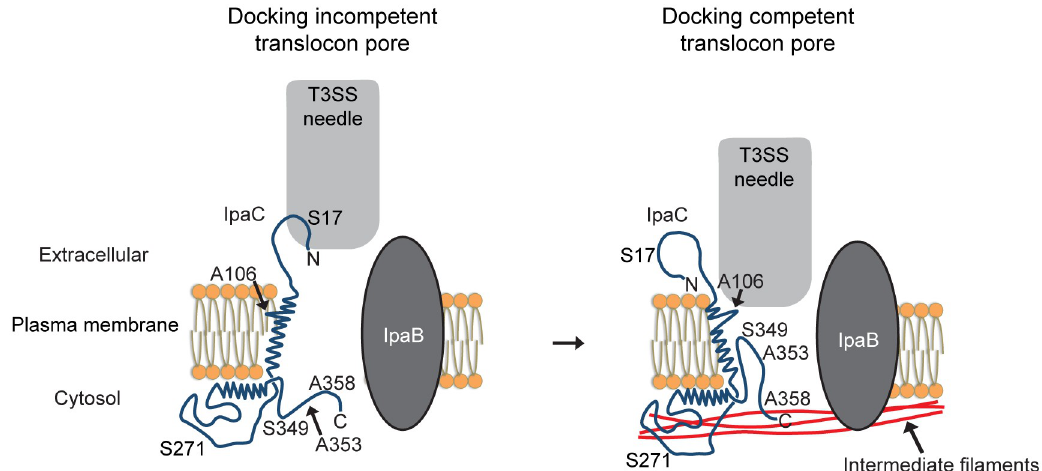
Fig 5. Model of conformational changes induced by interaction of IpaC with intermediate filaments. The translocon pore is formed in the plasma membrane such that the N-terminal region is extracellular and that the C-terminal region is cytosolic [23]. In the absence of an interaction between IpaC and intermediate filaments, residues A106, S349, and A353 are not readily accessible from the extracellular space. Interaction of IpaC with intermediate filaments is associated with significantly greater extracellular accessibility of A106, S349, A353, and S17C. In contrast, IpaC interaction with intermediate filaments does not alter the accessibility of A358 or S271.